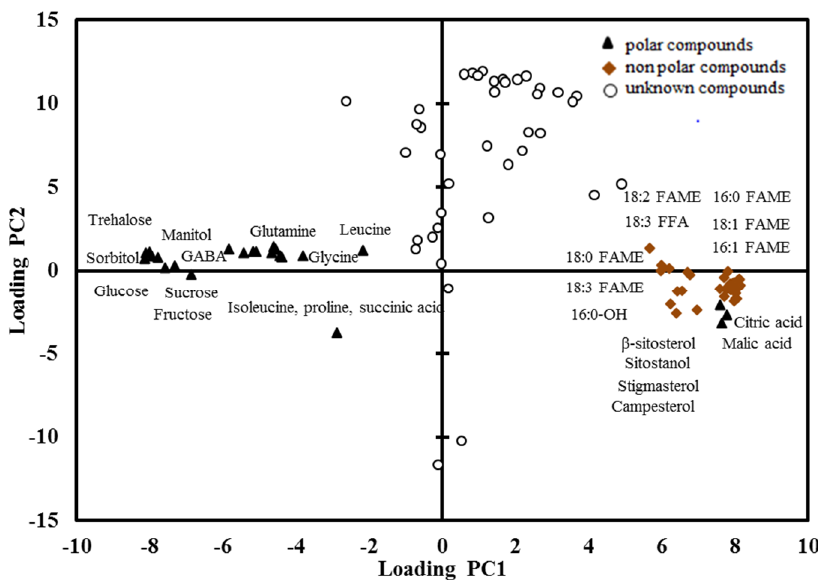
Figure 3. Principal component analysis of the combined metabolites at different ripening stages (0, 2, 4, 6, and 8 days of ripening) in mangoes. STD, dry season ‘Nam Dok Mai Si Thong’ ( ); STR, rainy season ‘Nam Dok Mai Si Thong’ ( ); NFD, dry season ‘Nam Dok Mai No. 4’ ( ); NFR, rainy season ‘Nam Dok Mai No. 4’ ( ). Figure 4. Loading plots of standardized GC/FID metabolite compounds (16:0 (palmitic acid), 16:1 (palmitoleic acid), 18:0 (stearic acid), 18:1 (oleic acid), 18:2 (linoleic acid), 18:3 (linolenic acid) and GABA (gamma aminobutyric acid) from the combined non-polar and polar fractions. Polar compounds ( ). FAME, fatty acid methyl ester; FFA, free fatty acid; GABA, gamma aminobutyric